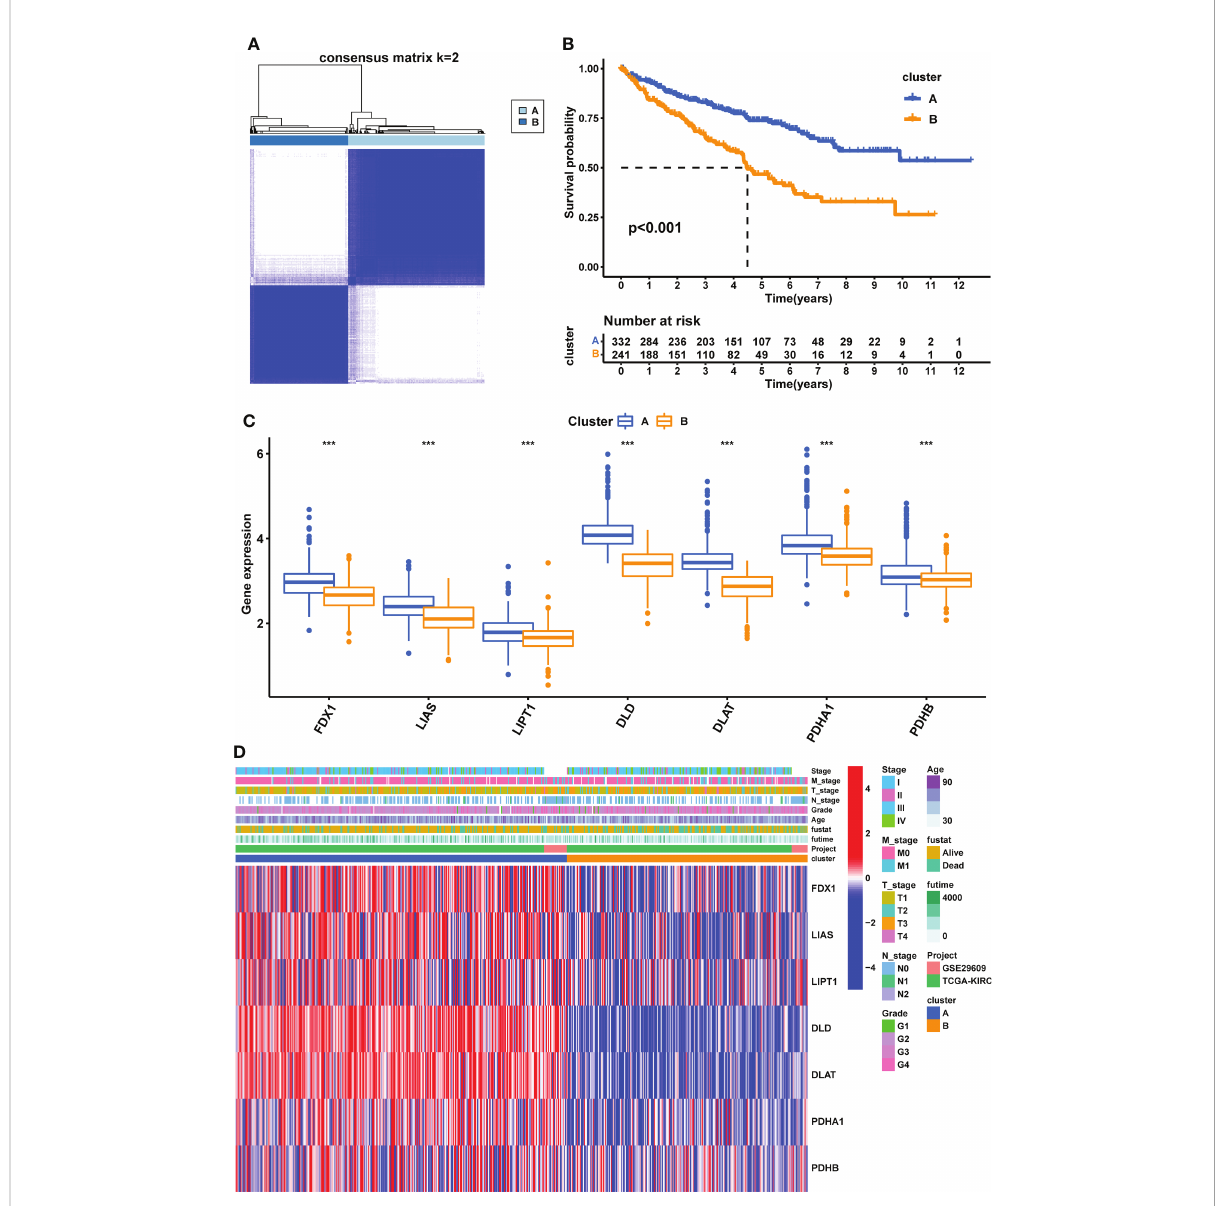
FIGURE 3 Construction of CPG subtypes and exploration about clinical and biological features of subtypes. (A) consensus matrix that divides all KIRC samples into two clusters (k=2). (B) Kaplan – Meier curves for the two subtypes of KIRC patients (OS, Log-rank test, p < 0.001). (C) Expression differences of seven CPGs between the two subtypes. (D) Heatmap of the distribution of clinicopathological features and CPG expression between two different subtypes. CPG, cuproptosis-promoting gene; ***p <